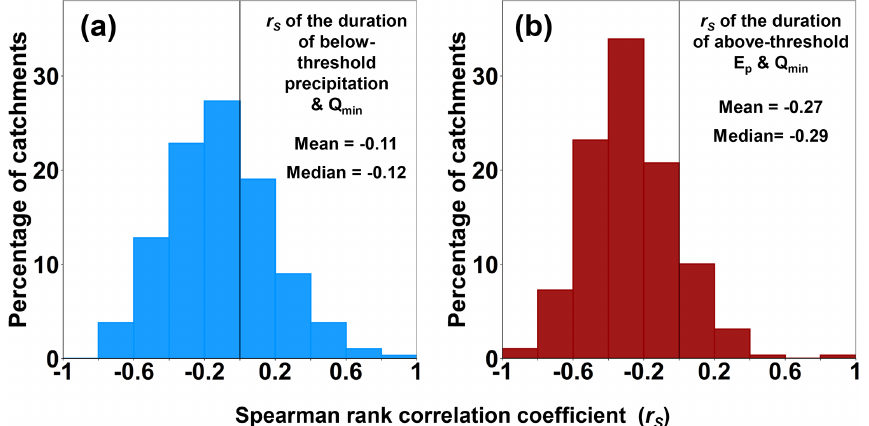
Figure 4. Histograms of rank correlations between the magnitudes of warm-season low flows and the lengths of the preceding intervals with below-threshold precipitation (a) or above-threshold E p (b) . Longer periods of high E p are associated with lower low flows, whereas a weaker association is seen between lower low flows and longer periods with low precipitation.